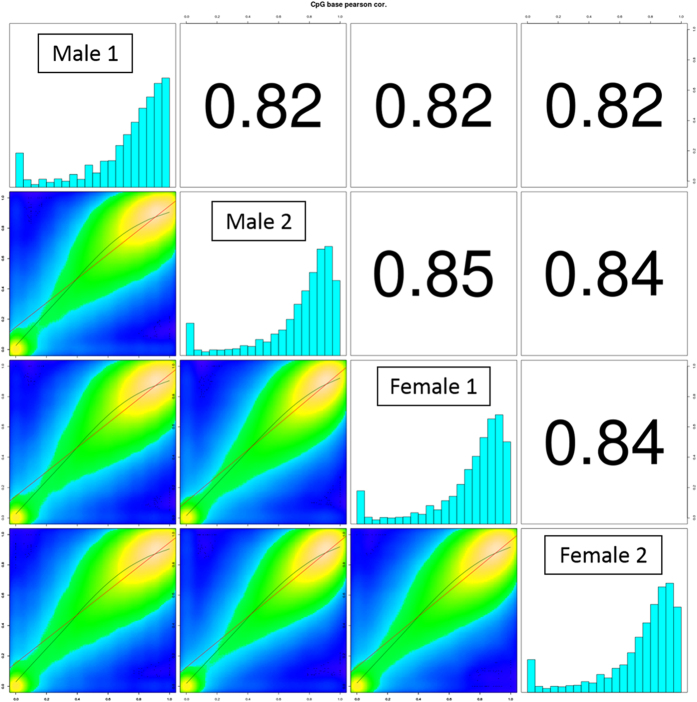
Correlation matrix showing the Pearson correlation of base resolution CpG methylation genome-wide between the skeletal muscle tissue samples of hybrid tilapia.Histograms showed CpG methylation level of each sample from 0% to 100% distributed across 20 bins of 5% intervals. The red line and green line represent linear regression and loess fit, respectively, to model the relationship of differential CpG methylation sites between compared individual pairs. Comparing the genome-wide CpG methylation profile between the sexes showed similar CpG methylation profiles in skeletal muscle tissue, with obvious differences between the sexes. Also, majority of CpG sites are highly methylated, with most of the CpG sites at more than 75% methylation level.